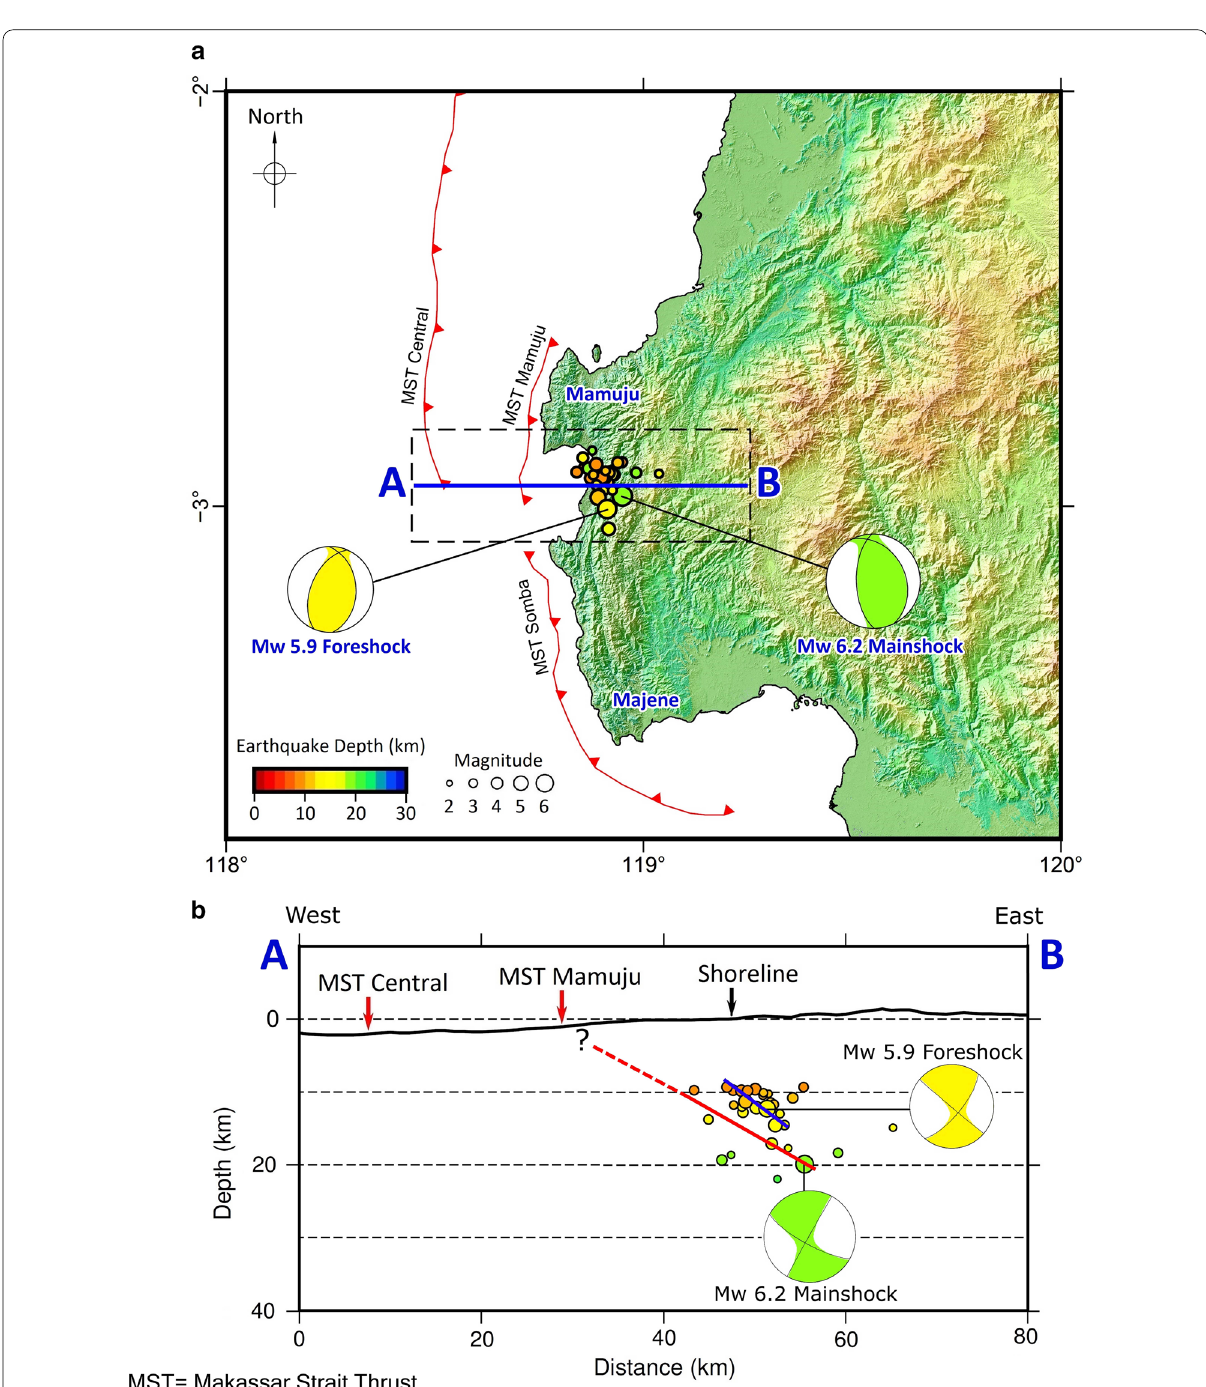
Fig. 3 a Map view of relocated events and focal mechanism solutions for a Mw 5.9 foreshock and the Mw 6.2 mainshock from the BMKG catalog; b cross-section A–B in West–East direction showing relocated events, focal mechanisms, and an interpretation of how multiple faults cause the earthquake sequence. The solid and dashed red lines suggest that the Mw 6.2 mainshock fault plane rupture is probably associated with MST Mamuju, while the solid blue line highlights the fault plane rupture based on the Mw 5.9 foreshock focal mechanism and aftershock hypocenter